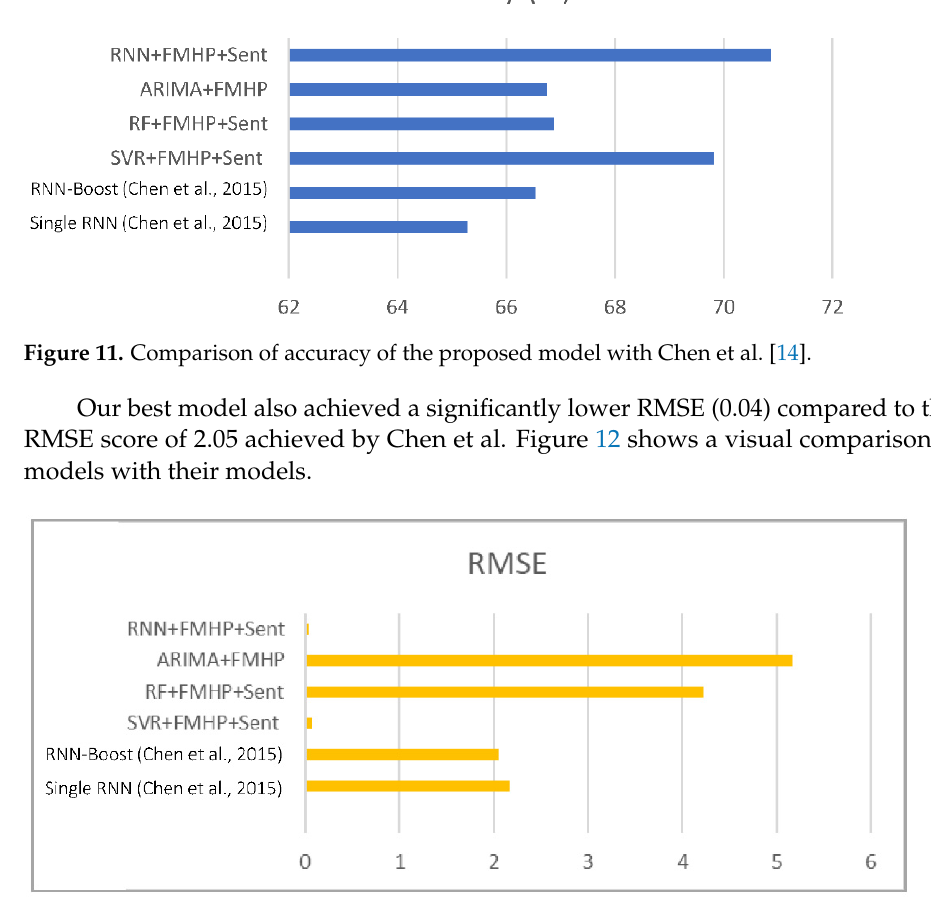
Figure 12. Comparison of RMSE of the proposed model with Chen et al. [14]